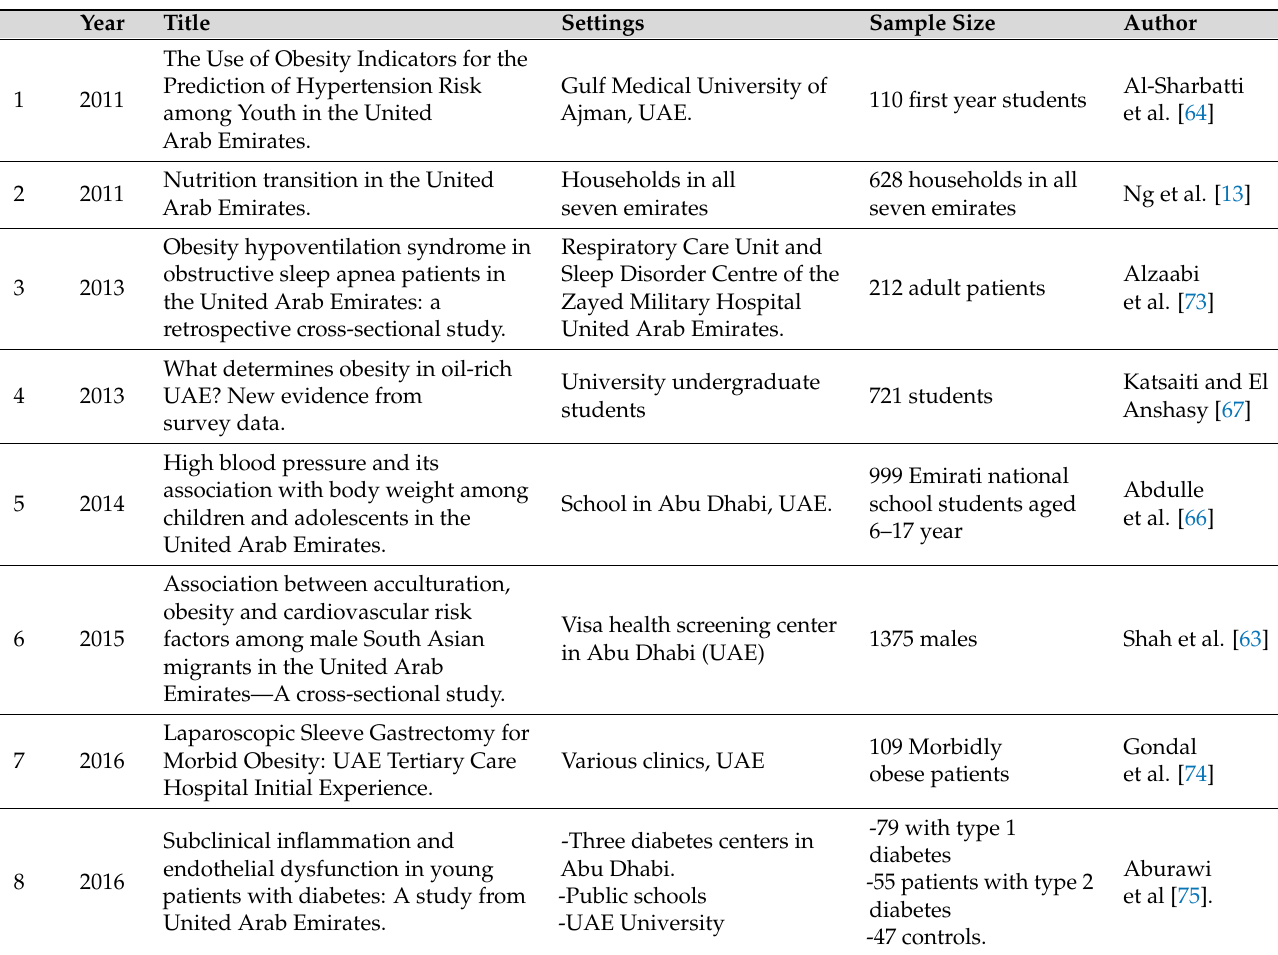
Table 3. Overweight and Obesity in